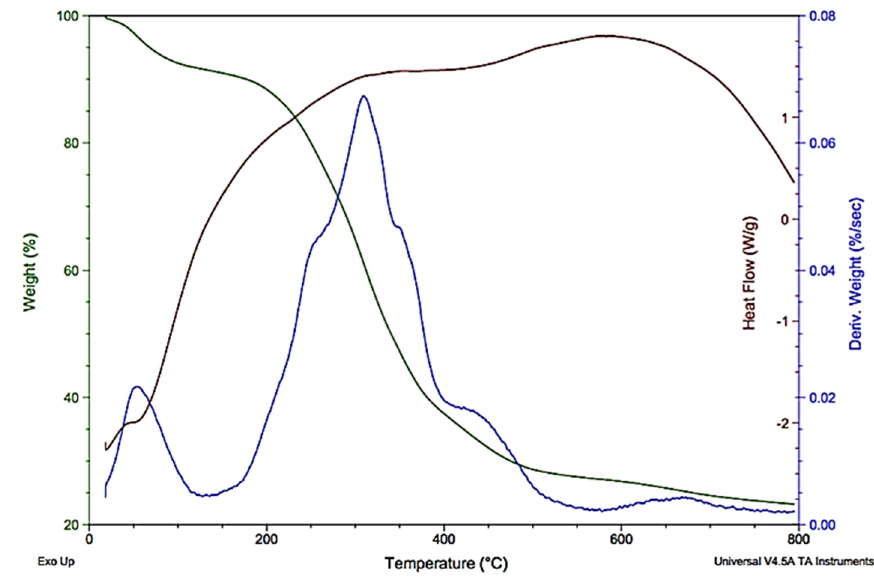
Figure 4. TGA/DTA Analysis .